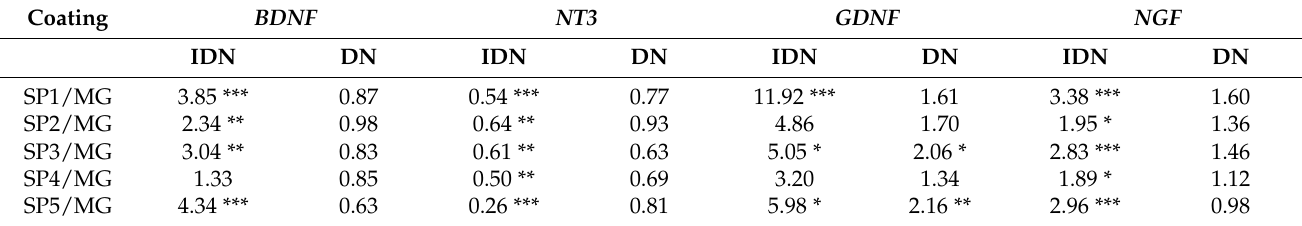
Table 7. Effect of cell cultivation on CCs on the levels of NTF gene transcription in the forming IDNs and DNs. Coating BDNF